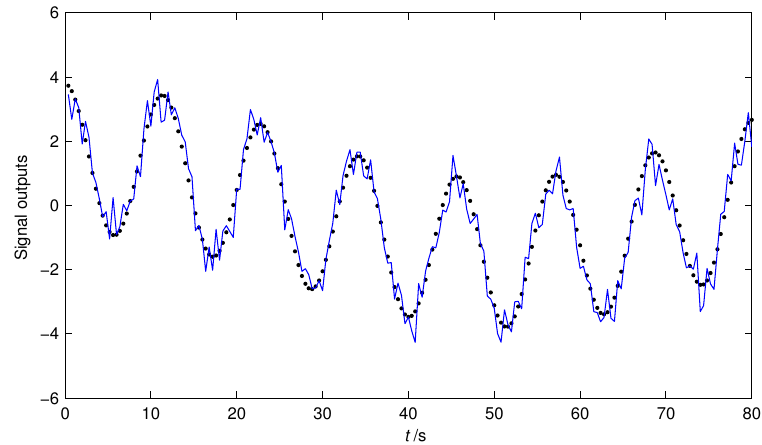
Figure 4. The estimated outputs ˆ y ( t ) and the actual signal model y ( t ) versus t . Solid line: the actual output y ( t ) , dot-line: the estimated signal ˆ y ( t )